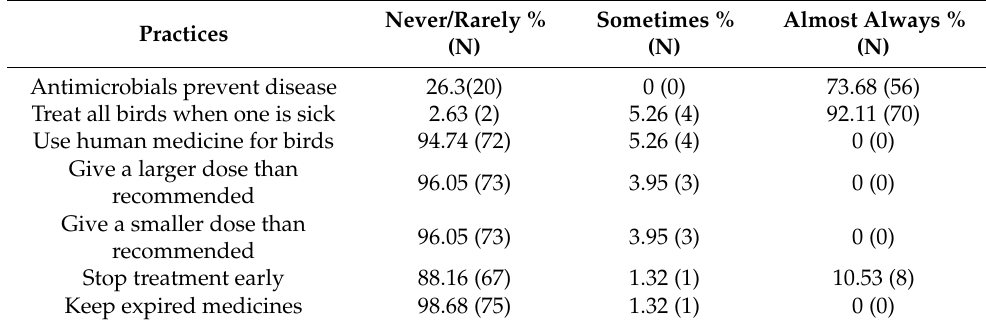
Table 2. Antimicrobial use (AMU)